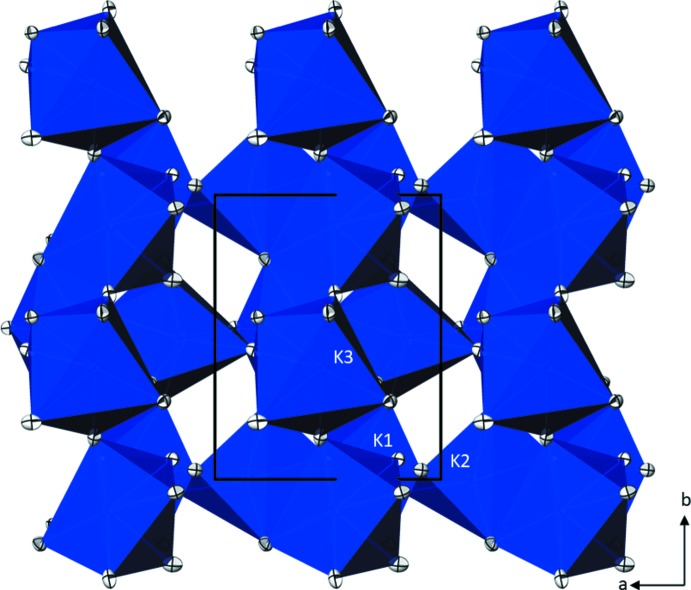
Network of corner- and edge-sharing [KO7] polyhedra in the crystal structure of K3PO4·7D2O, viewed along [00]. Displacement ellipsoids are displayed at the 90% probability level. For clarity, D atoms are not shown.